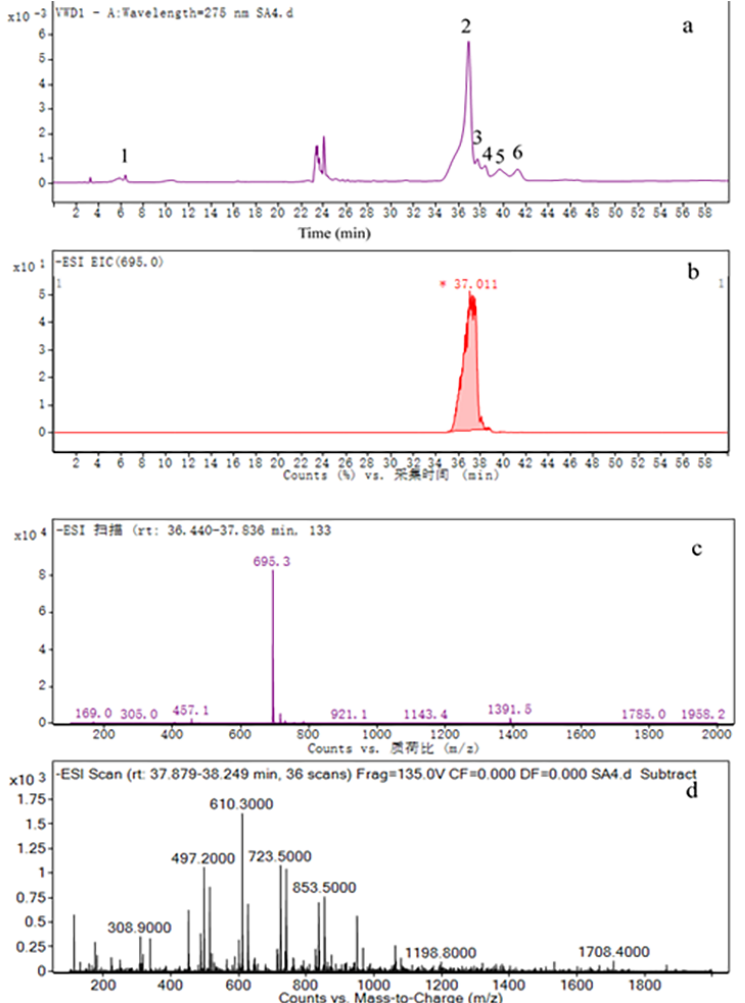
Figure 6. HPLC-MS analysis of product under the optimum condition (EGCG/palmitoyl chlo- ride/sodium acetate = 1:2:2), ( a ) chromatogram of the product; ( b ) selective ion chromatogram of PEGCG (m/z 695); ( c ) mass spectra of PEGCG (Mw 696.8); ( d ) mass spectra of peak 3.